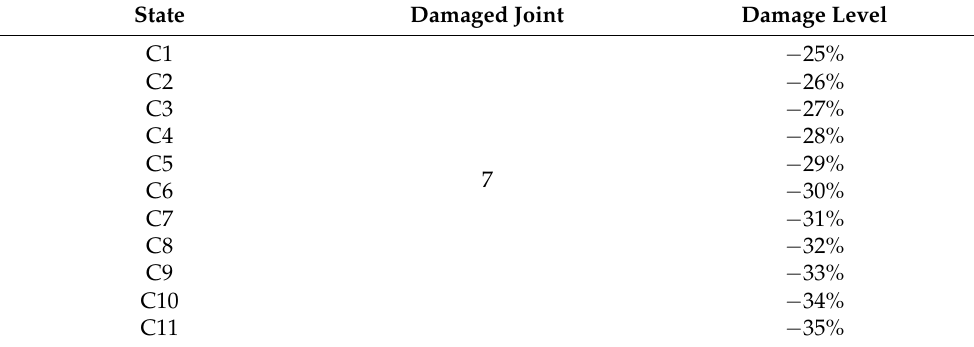
Table 5. Test case C.